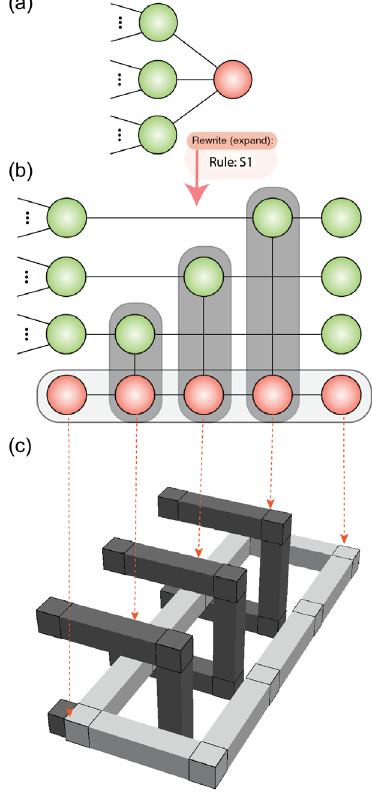
FIG. 5. Translation example. (a) Partial ZX-circuit illustrating a typical connected red spider node. (b) Expansion of the same circuit through the application of the S1 rule leading to a set of CNOT gates, initializations, and measurements. CNOT gate iden- tification allows us to reduce the number of merge and split operations (and associated qubits) through braiding. (c) Associ- ated 3D encoded circuit where the primal defect is identified with the red spider node. The identification of spider nodes with closed loops allows the nodes of the ZX-graph to be interpreted as qubits (in lieu of